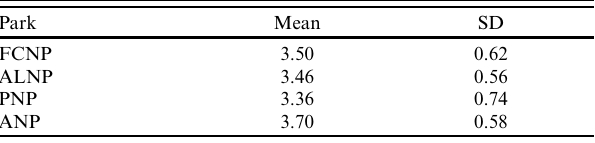
Table 2 . Means and standard deviations (SD) of quantitative questions across the four surveyed national parks. NOTE: